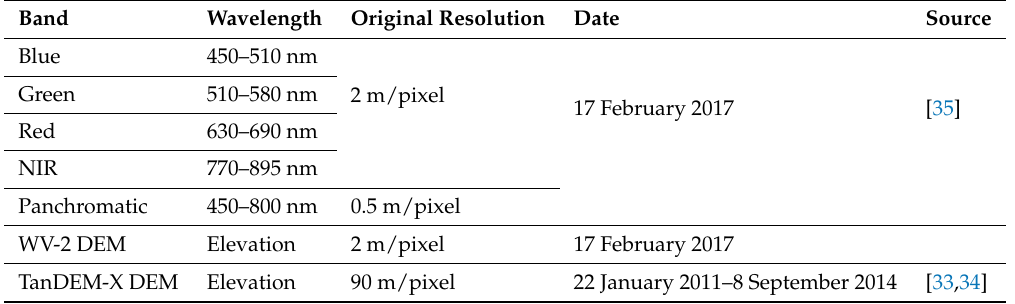
Table 1. List of the datasets used for iceberg inventory creation and DEM quality assessment.